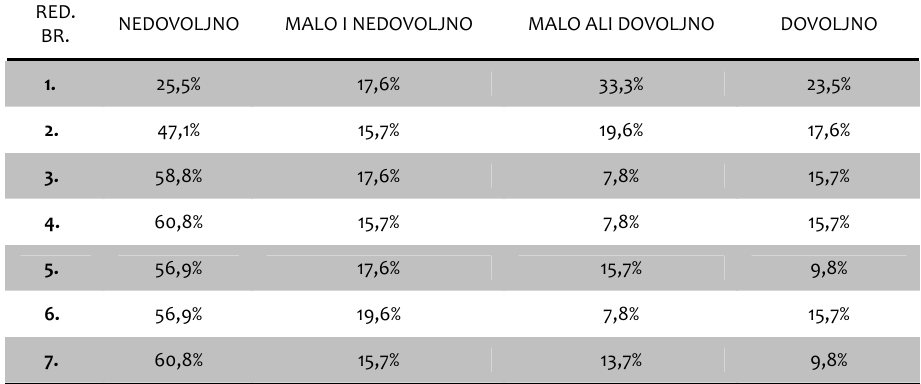
Posmatrajući Tabelu 3, zaključujemo da se internet kao nastavno sredstvo u ovoj školi ipak koristi. Učenici su, sudeći prema rezultatima istraživanja, i te kako svesni činjenice da bi internet u nastavi trebalo upotrebljavati daleko više. Međutim, određeni broj učenika je zadovoljan i sadašnjim stanjem izjašnjavajući se, shodno tome, da se internet u nastavi ipak koristi dovoljno , odnosno malo ali dovoljno (što se može videti kod pitanja br. 1 – „da li nastavnici koriste internet u toku časa kao nastavno sredstvo”). Ovim je naša treća hipoteza, kojom se pretpostavlja da se internet i Jutjub u nastavi uopšte ne koriste, opovrgnuta. Pomenuti stav nekolicine učenika da se internet ipak dovoljno , odnosno malo ali